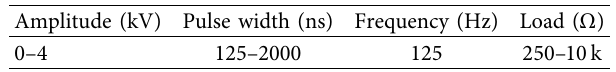
Figure 6: The complete unit of the compact high-voltage pulse generator developed in this study: (a) the dimension of the pulse generator and (b) practical test setup. Table 2: A set of testing parameters for the simulation